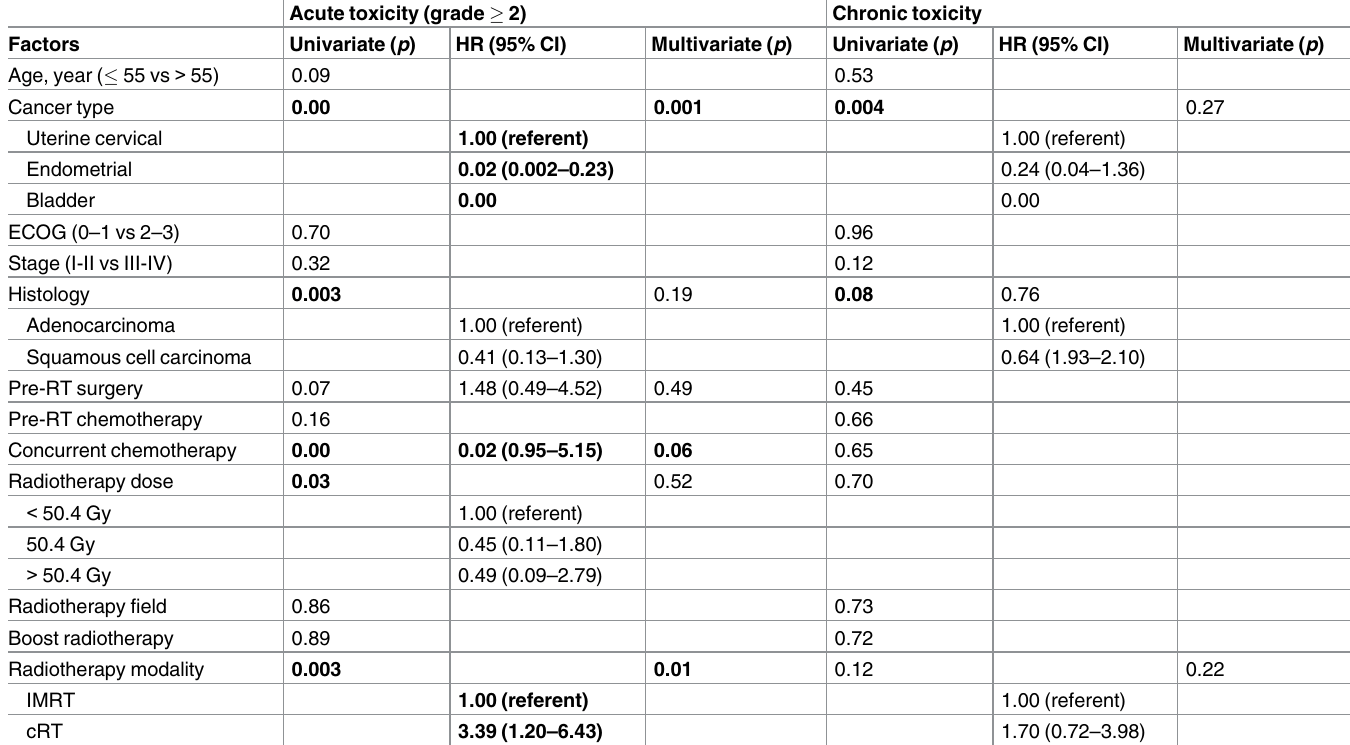
Table 2. Factors that affect toxicity in pelvis